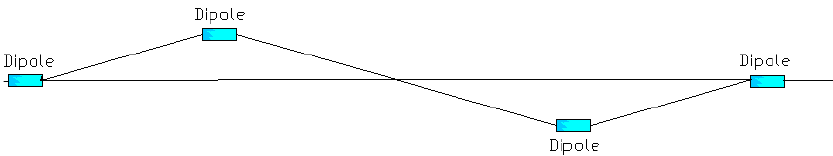
FIG. 5. (Color) Schematic layout of the compact zigzag chicane.